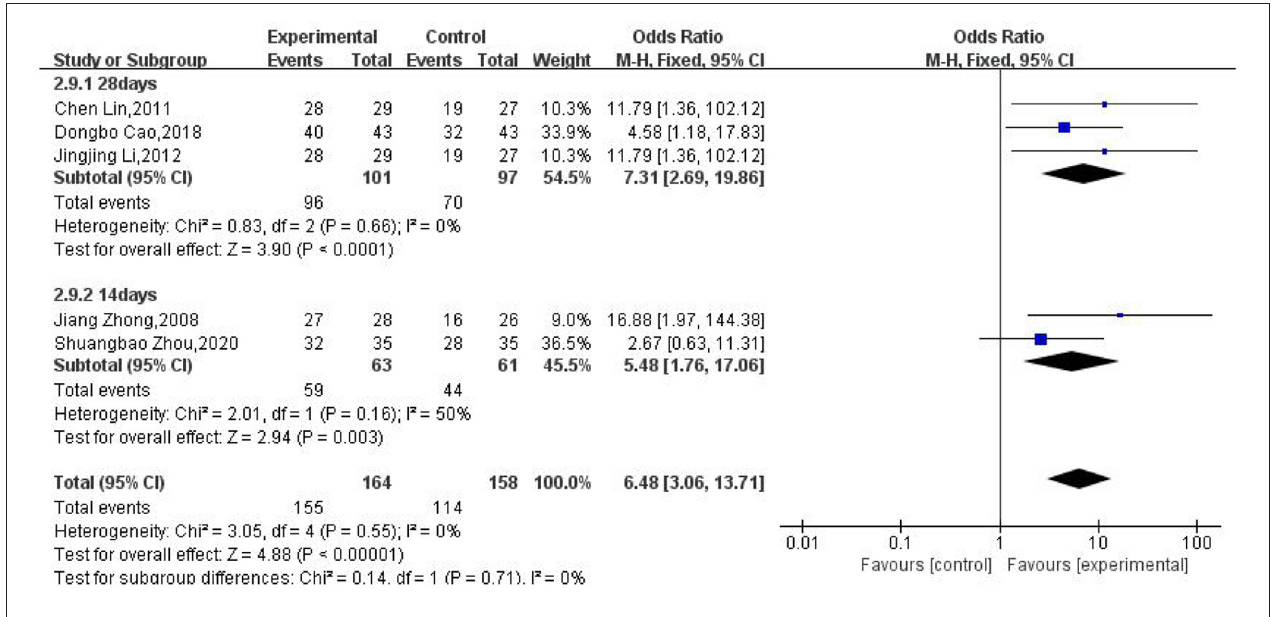
FIGURE 5 | Subgroup analysis of different treatment courses.